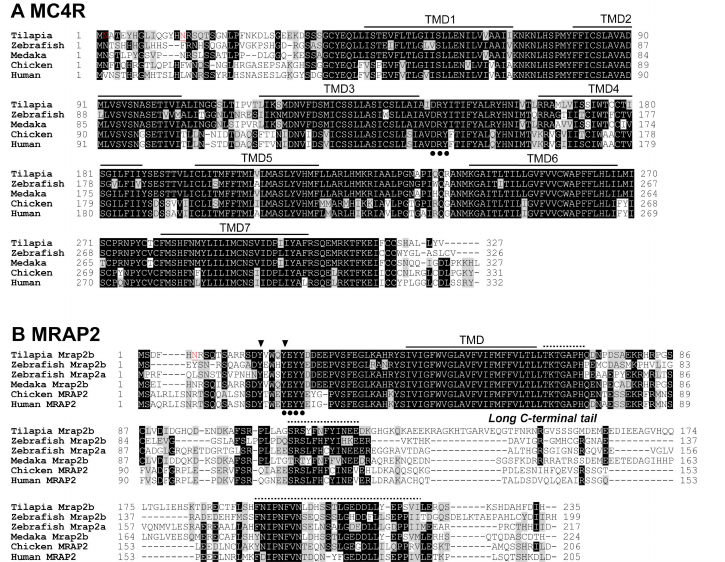
Figure 1. Synteny analysis of MRAP2 ( A ), POMC ( B ), and their neighboring genes in Nile tilapia, zebrafish, Japanese medaka, Xenopus tropicalis , chickens, and humans. Orthologs are aligned in the same pentagon with the same color. The gene names are placed on top of the pentagons, and MRAP2 (or POMC ) gene was highlight with red background. Chromosome (Chr.) numbers are represented above the genes or listed on the right, and the locations (in megabase, Mb) on the chromosomes are shown below the genes based on the information from ENSEMBL databases. In some teleost species (e.g., zebrafish), two copies of MRAP2 generated by the 3rd round of genome duplication (3R) were designated as MRAP2a and MRAP2b , respectively. In tilapia and medaka, three POMCs ( POMCa1 , POMCa2 , and POMCb ) were identified, which were likely originated by the whole genome duplication events during vertebrate evolution.